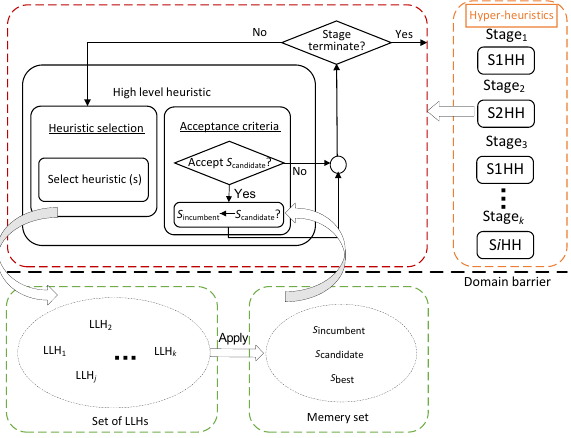
Fig. 1 Framework of the multi-stage hyper-heuristic